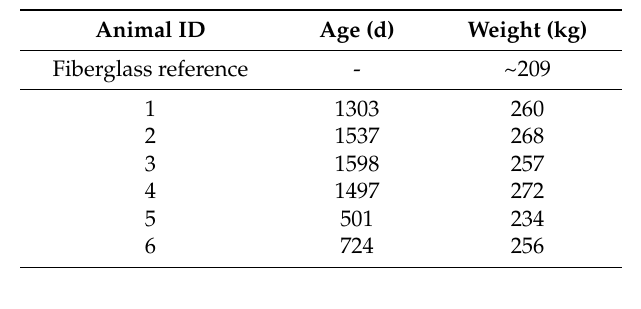
Table 1. Ages and weights of studied animals. For the fiberglass model, the weight of an animal with an equivalent size is